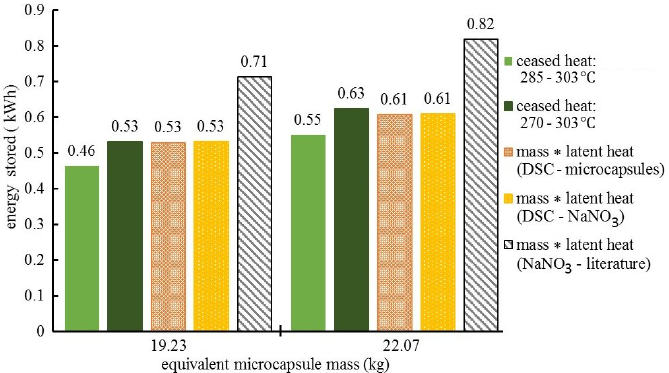
Figure 8. Storage tank evaluation of the latent heat thermal energy storage in microcapsules by adapted calorimetric method (ceased heat) and latent heat measurements at microscale. The columns labeled as mass * latent heat represent estimates of the tank-stored PCM solidification energy, and are provided by the mass–latent heat product for